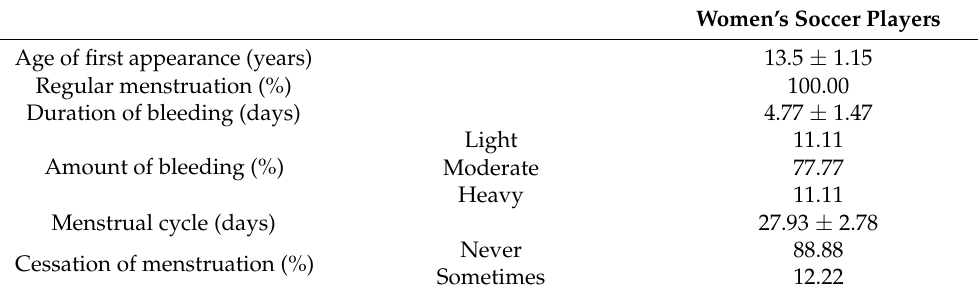
Table 2. Menstrual cycle